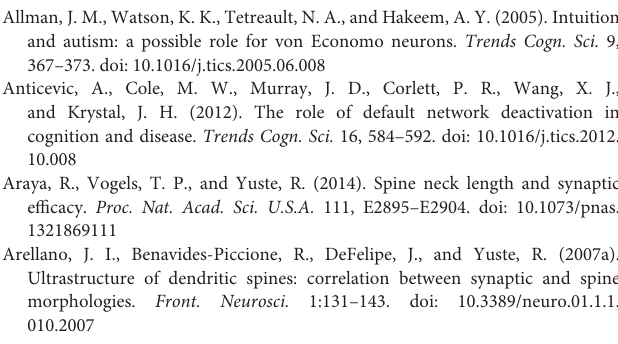
Supplementary Figure 1 | Three-dimensional reconstruction of layer V Golgi-impregnated from the human precuneus cortex (corresponding to Figure 5 ). Supplementary Figure 2 | Three-dimensional reconstruction of layer V Golgi-impregnated from the human precuneus cortex (corresponding to Figure 6 ). Supplementary Figure 3 | Three-dimensional reconstruction of layer V and in the transition to layer VI Golgi-impregnated from the human precuneus cortex (corresponding to Figure 7 ). Supplementary Figure 4 | Golgi-impregnated layer V pyramidal neuron from the human precuneus cortex (central region, 61.1 mm posterior to the midpoint of the anterior